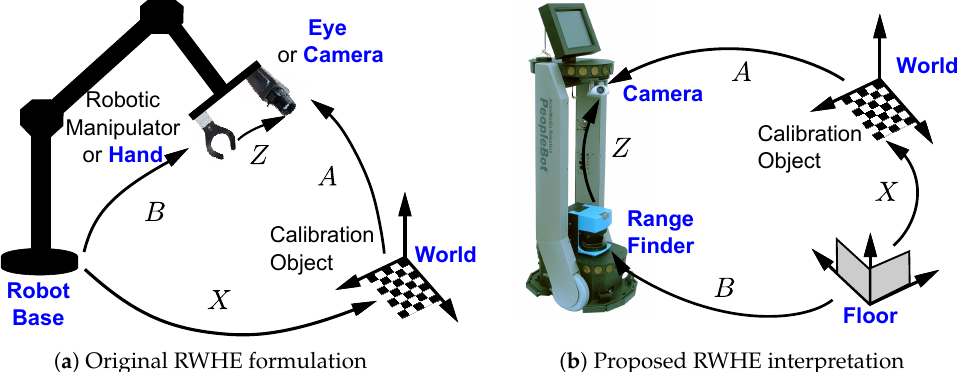
Figure 1. Hand–Eye Robot–World calibration formulation: ( a ) original; ( b ) proposed